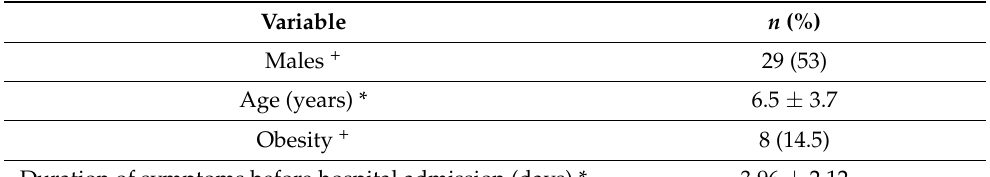
Table 1. Clinical and laboratory findings in 55 patients with MIS-C at hospital